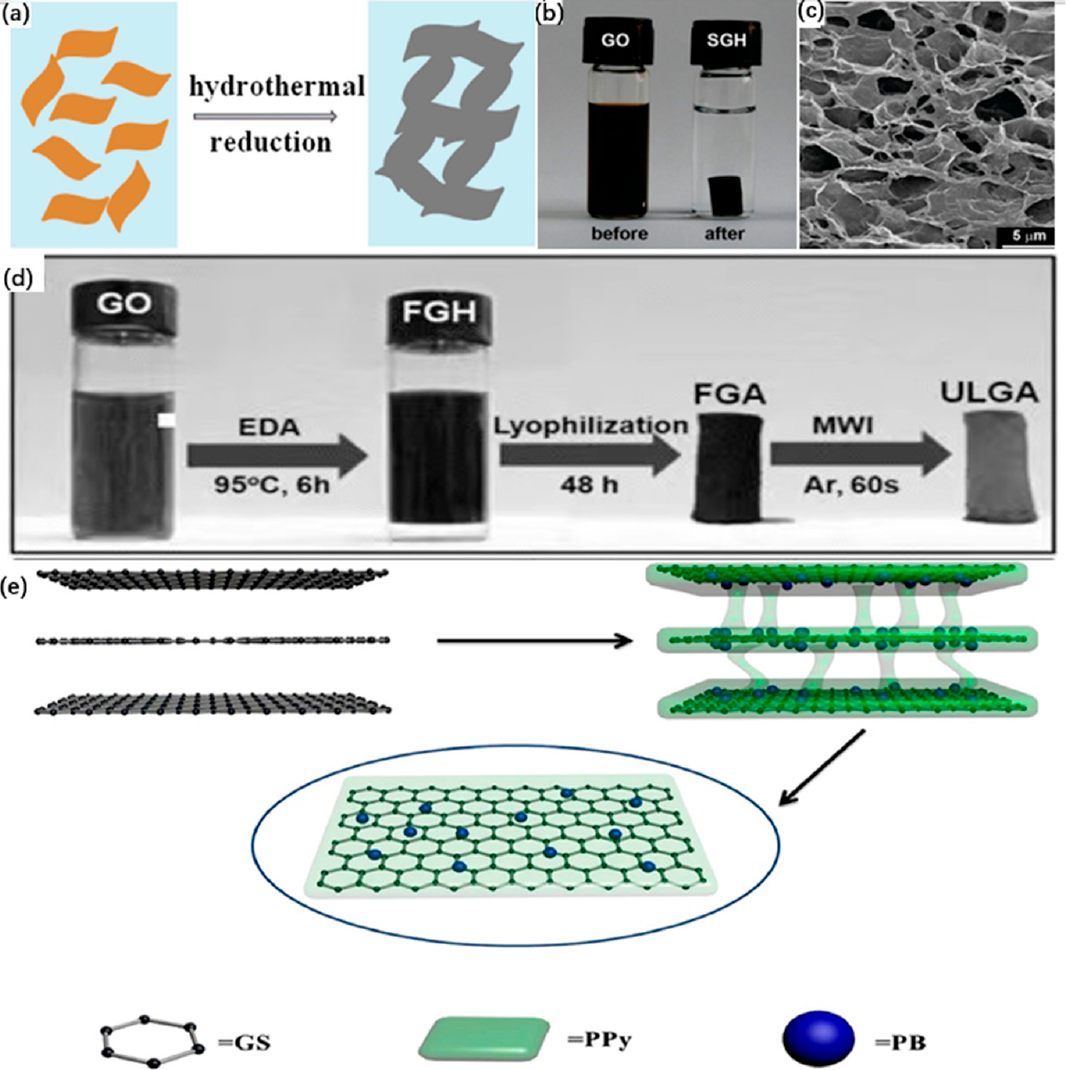
Figure 3. ( a ) The proposed formation mechanism for SGH; ( b ) Photos of GO aqueous dispersion after 12 h of hydrothermal assembly; ( c ) Photos of the internal microstructure of SGH under SEM [30]; ( d ) Illustration of the fabrication process of the ultralight graphene aerogel (ULGA) [7]; ( e ) Schematic diagram of polypyrrole (PPy) used as a crosslinking agent for GA assembly [36]. Compared to the harsh conditions of hydrothermal assembly, the synthesis of graphene hydrogels using chemical reductive assembly requires the addition of reducing agents (com- monly used agents are sodium ascorbate, hydroquinone, ethylenediamine, etc.) to chemi- cally reduce GO [31,37,38], which is more convenient to operate and thus widely adopted. Sheng et al. used sodium ascorbate to reduce GO to promote the three-dimensional as- sembly of graphene sheets, effectively removing the oxygen-containing functional